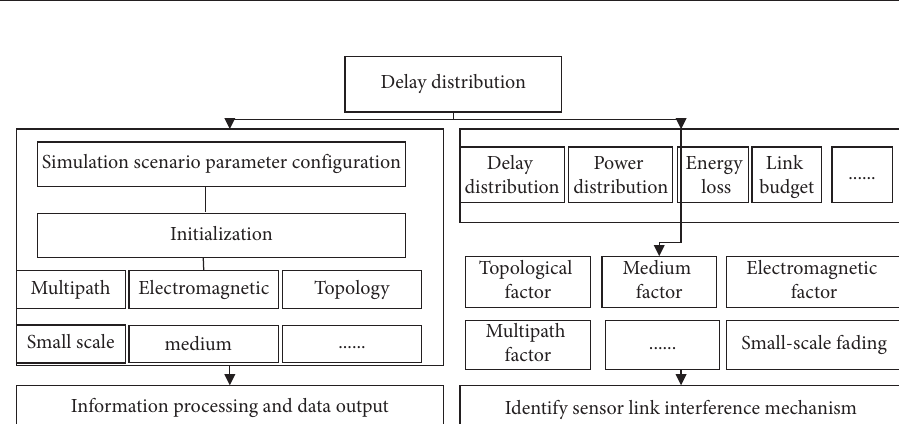
Figure 4: Flowchart of myoelectric signal